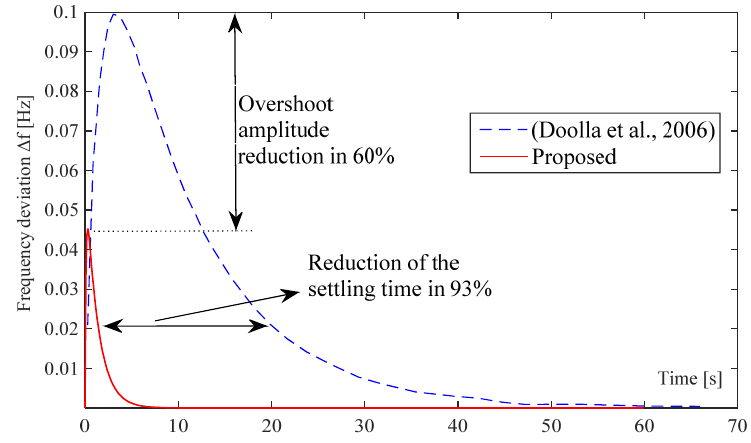
Figure 11. Frequency behavior for sustained loads of 10%. Validation results.